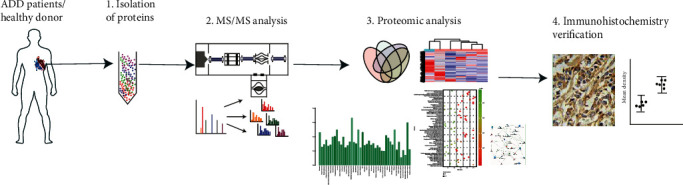
Experimental flowchart. The aortic arch tissues of 5 patients with AAD were extracted during surgery. The peptides labelled with TMT were prepared, and a MS/MS analysis was performed. The proteomic data were analyzed, and the DAPs were selected and verified by immunohistochemistry.